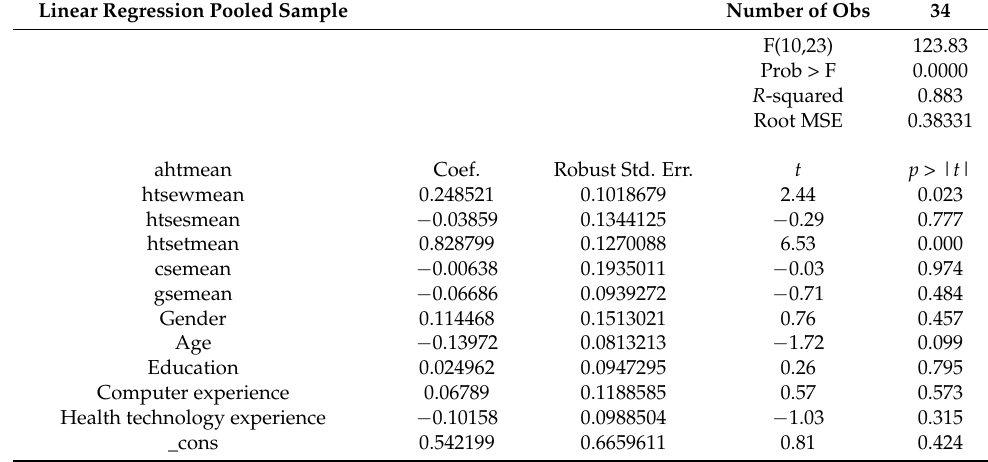
Table 4. Linear regression model output for total sample of app 1 (Jawbone) and app 2 (Fitbit) participants. Linear Regression Pooled